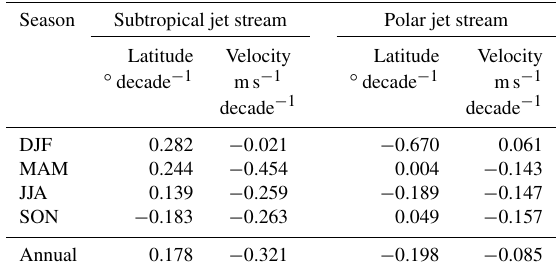
Table 2. Slope parameter for the latitude and velocity trends of the jet stream cores. Bold values indicate statistical significance ( p < 0.05) using Monte Carlo analysis with 10000 surrogate time series of shuffled